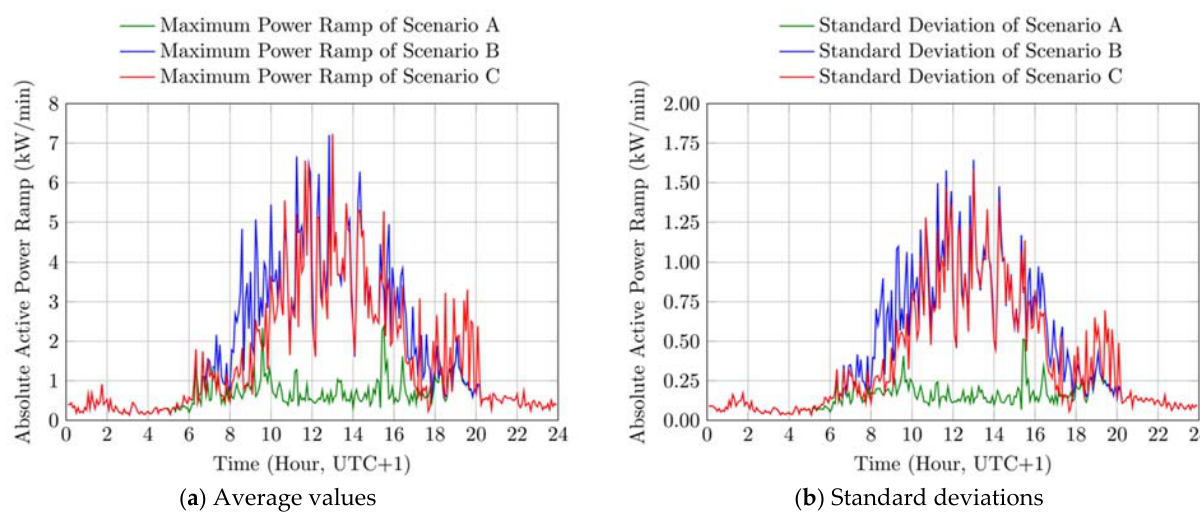
Figure 8. Absolute power ramp of the active net power flow at the PCC with the main grid for Scenarios A, B, and C during May 2020. In sub ‐ figure ( a ), the average values of the power ramp are shown, while sub ‐ figure ( b ) reports the standard deviation of the measurements for each 𝑖 ‐ th time interval. UTC: universal time coordinated.